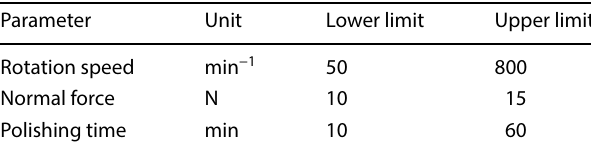
Table 2 Listing of the input parameters for the